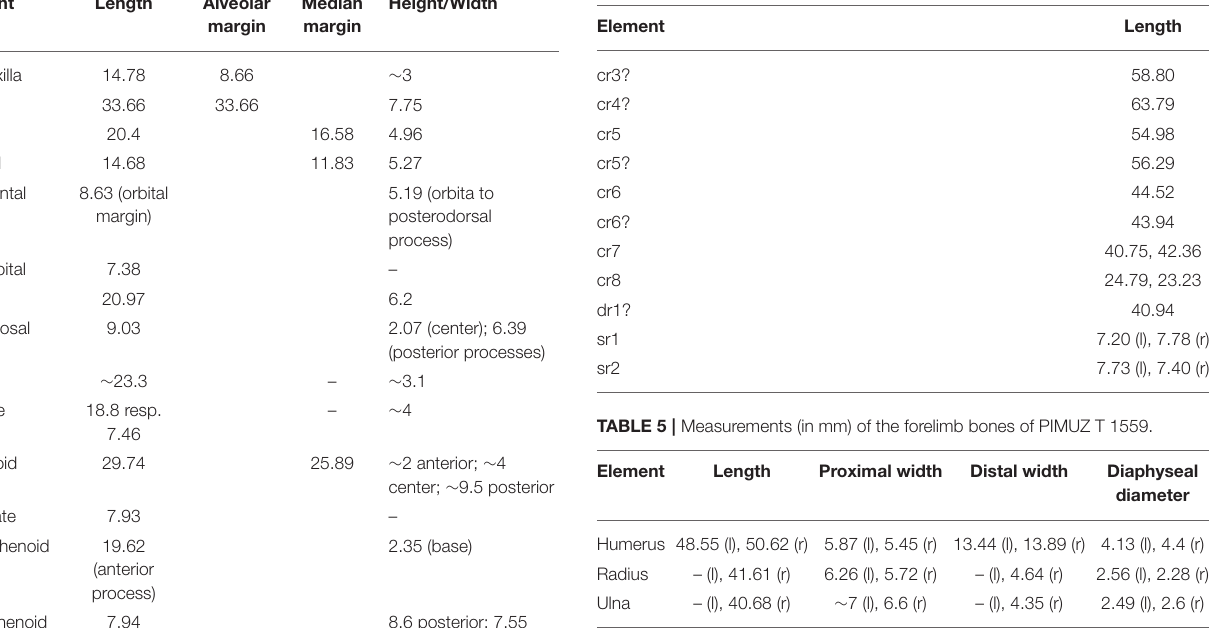
TABLE 4 | Measurements (in mm) of maximum lengths of the cervical ribs (cr), the first thoracic rib (dr), and the sacral ribs (sr) in PIMUZ T 1559.